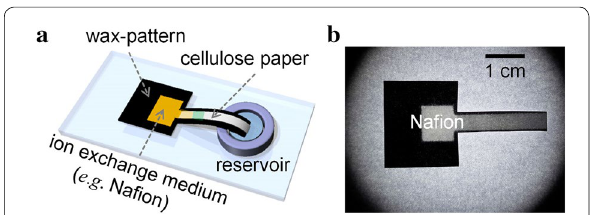
Fig. 1 a Schematic and b the image of a paper-based